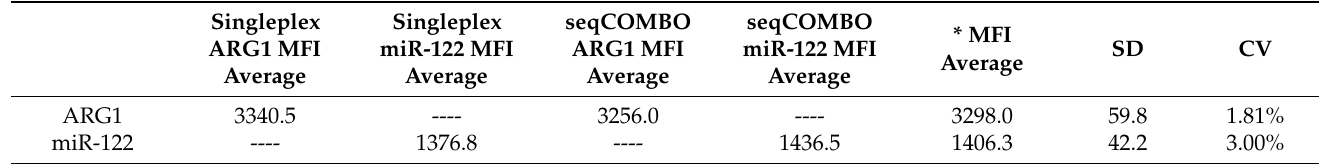
Figure 3. SeqCOMBO workflow. Step 1—anti-ARG1 beads are added to the serum sample; Step 2—anti-ARG1 beads capture the ARG1 and separated from the supernatant (see Step 4); Step 3— the supernatant is added with Stabiltech buffer containing DGL-122 beads; Step 4— anti-ARG1 beads are reserved in assay buffer; Step 5—DGL-122 beads hybridize miR-122; Step 6—both sets of beads are merged; Step 7—the detection antibody and SMART-C biotin are added to the mixture of anti-ARG1 and DGL-122 beads; Step 8—beads are labelled with SA-PE; Step 9—the two regions are read out with the MAGPIX instrument. Phycoerythrin with excitation at 488 nm and emission at 585 nm. Table 1. Inter-CV comparative analysis for singleplex vs. seqCOMBO.